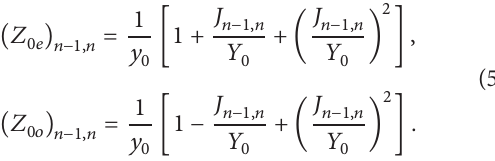
Figure 2: Laired distribution of the resonator substrate material.